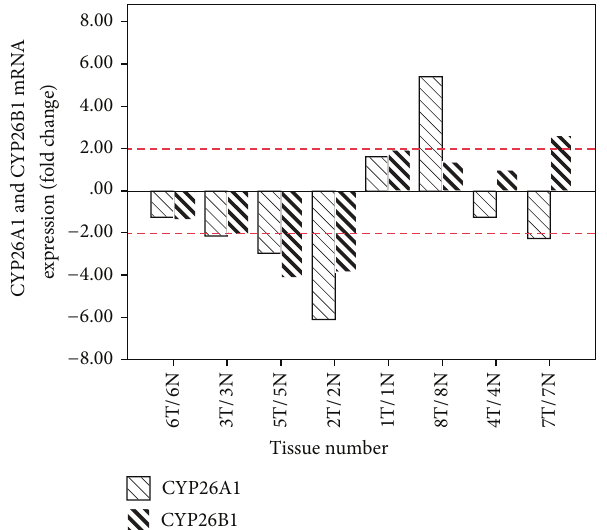
Figure 1: The induced mRNA of CYP26A1 and CYP26B1 in human oral cancer tissue (T) and its adjacent normal tissue (N). Paired tissue samples (tumor and adjacent normal tissue) without chemotherapy/radiation therapy were analyzed. Compared with human adjacent tissue ( 𝑁 = 8 ), the relative fold change was calculated in triplicate (columns, mean; bars, SD) using the formula 2 −ΔΔ Ct